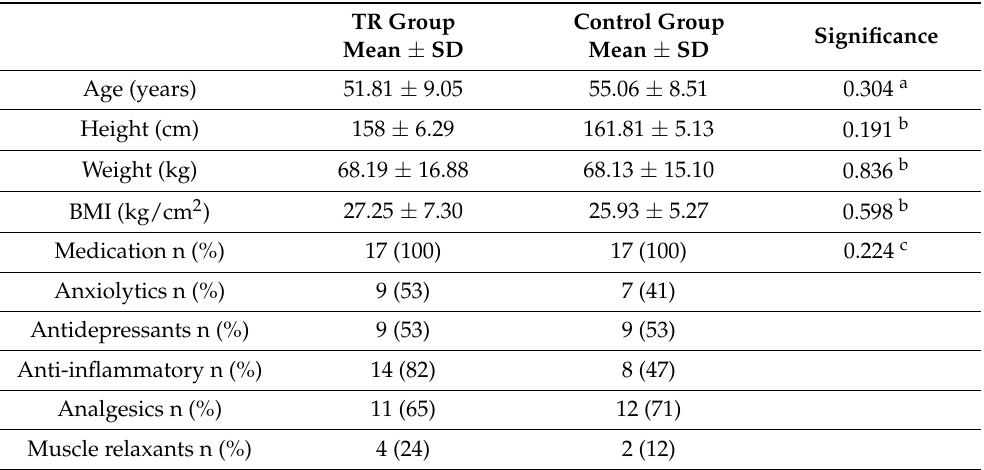
Table 1. Sociodemographic characteristics and medication intakes at baseline.